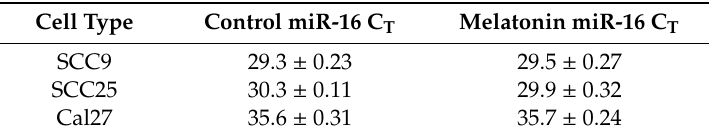
Table 1. Analysis of miR-16